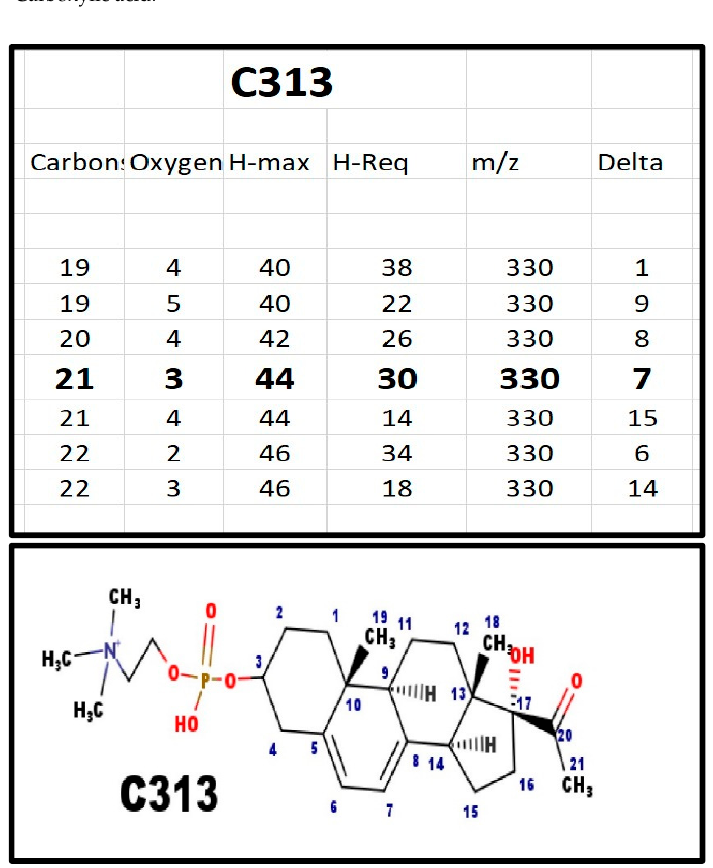
Figure A1. The proposed structures of C313.